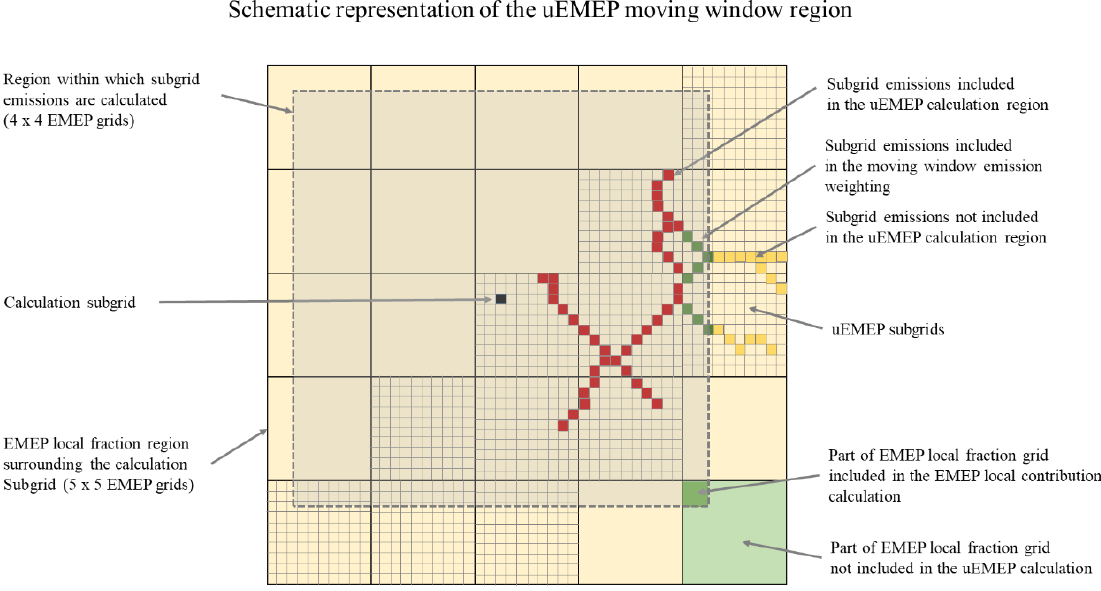
Figure 1. Schematic representation of the moving window region. It shows the regions used for uEMEP calculations and the area and emission weighting selection used to determine the local and non-local EMEP contributions at the calculation (receptor) subgrid. The extent of the subgrids is only partially